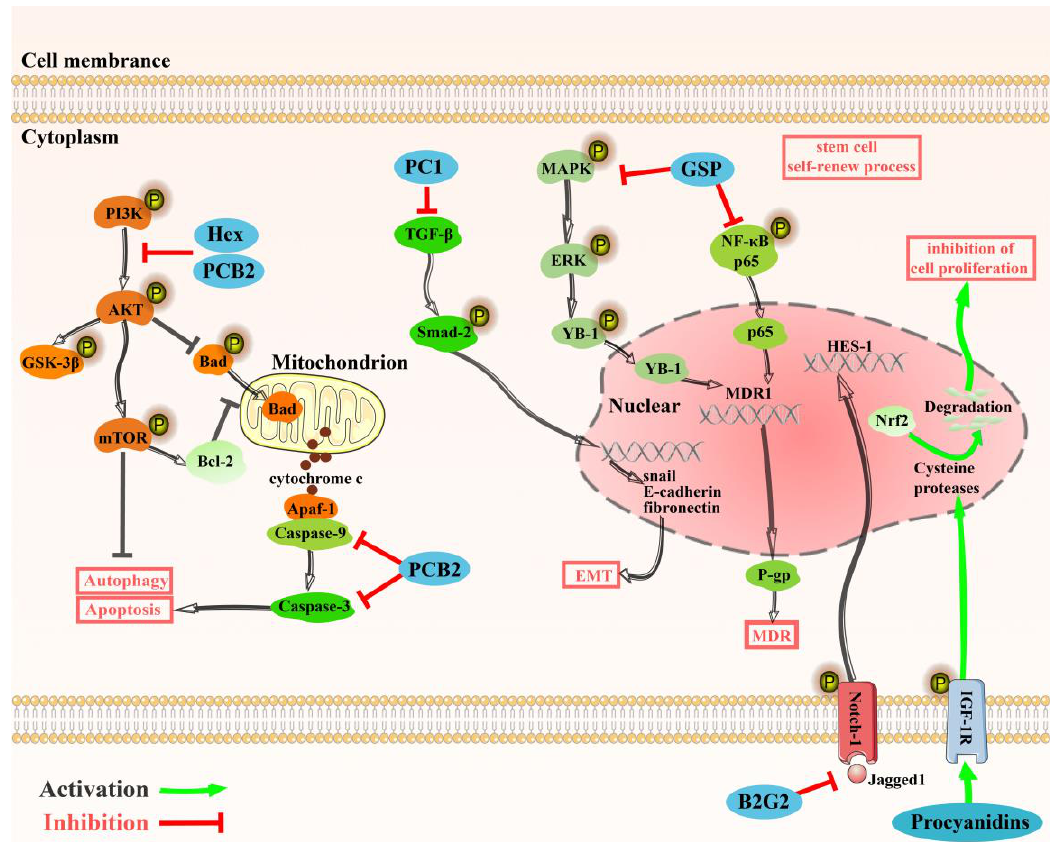
Figure 3. The antineoplastic mechanism of procyanidins. Notes: (1). Procyanidins can inhibit cell proliferation by phosphorylated IGF-1R, which can activate cysteine proteases and accelerate the degradation of activated Nrf2. (2). B2G2 can inhibit stem cell self-renew process through inhibiting the activitation of Notch1 pathway. (3). GSP can reverse MDR by suppressing both MAPK/ERK/YB- 1 and NF- κ B p65 pathway. (4). PC1 inhibits EMT by inhibiting TGF- β -induced phosphorylation of Smad-2, and further down-regulates Snail, E-cadherin and fibronectin. (5). HEX can inhibit PI3K/Akt/GSK- 3β and PI3K/Akt/Bad signaling pathways, and induce the mitochondrial apoptosis pathway of cancer cells. In addition, PCB2 also plays an anti-proliferative role and stimulates apoptosis, induces autophagy of cancer cells through the Akt/mTOR pathway. Abbreviation: IGF-1R, insulin-like growth factor 1 receptor; B2G2, B2 3;3 ″ -di-O-gallate; MDR, multidrug resistance; GSP, grape seed procyanidins; P-gp, p-glycoprotein; YB-1, Y-box binding protein 1; EMT, Epithelial-to- mesenchymal transition; PC1, procyanidin C1; Hex, hexamer; Bcl-2, B-cell lymphoma-2.